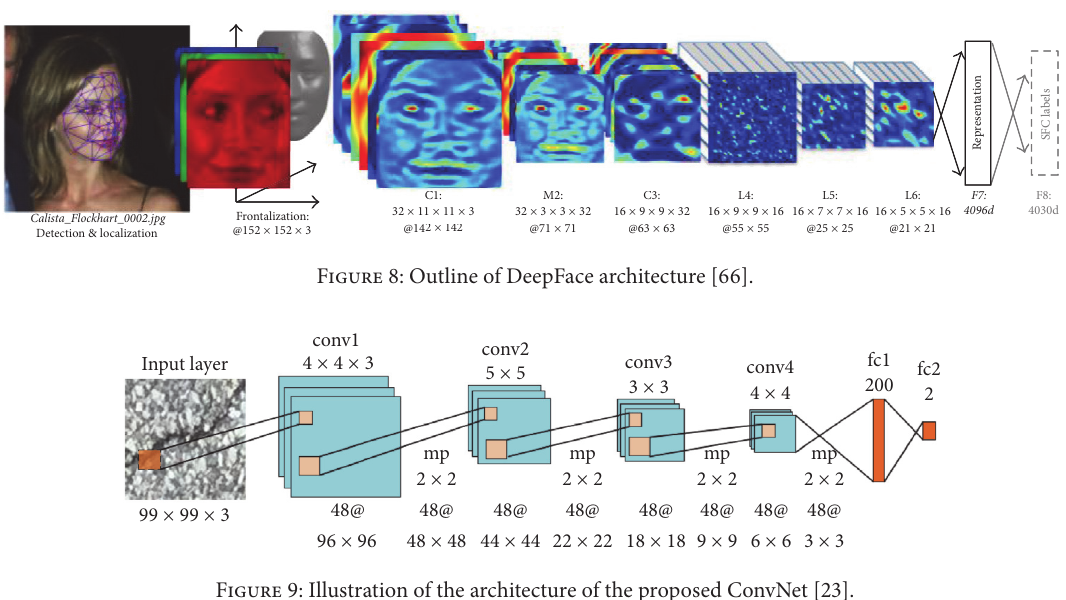
Figure 9: Illustration of the architecture of the proposed ConvNet [23].